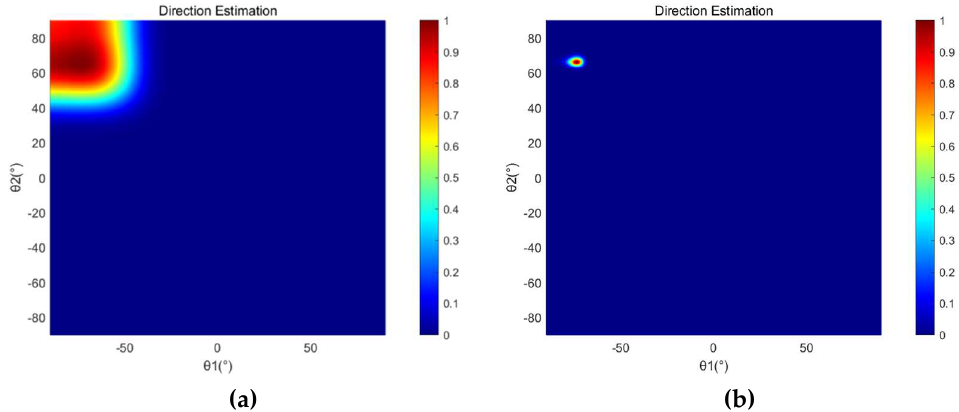
Figure 5. The direction estimation simulation results of (a) SRP-PHAT and (b) SRP-MCCC when the SNR is −5 dB.